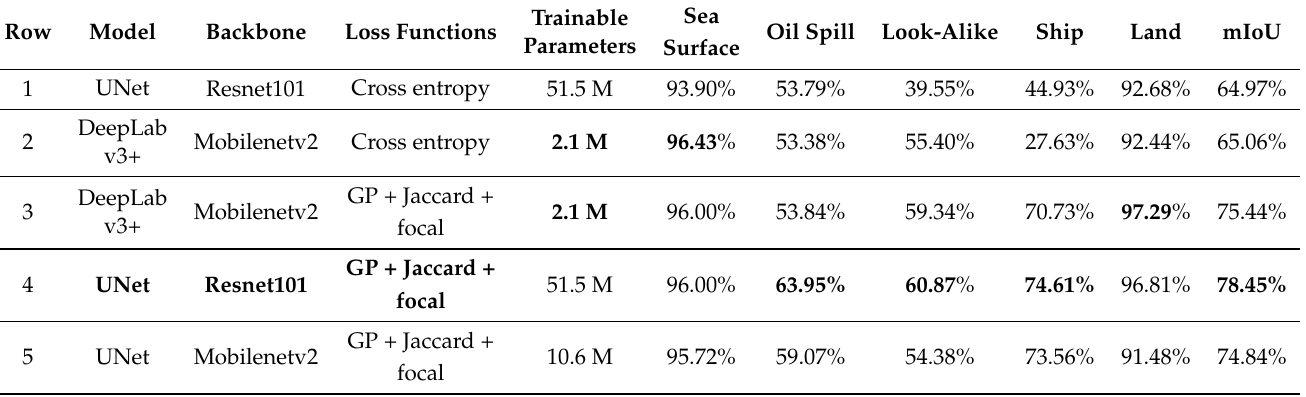
Table 1. Comparison of classification results with the state of the art (as reported by the earlier